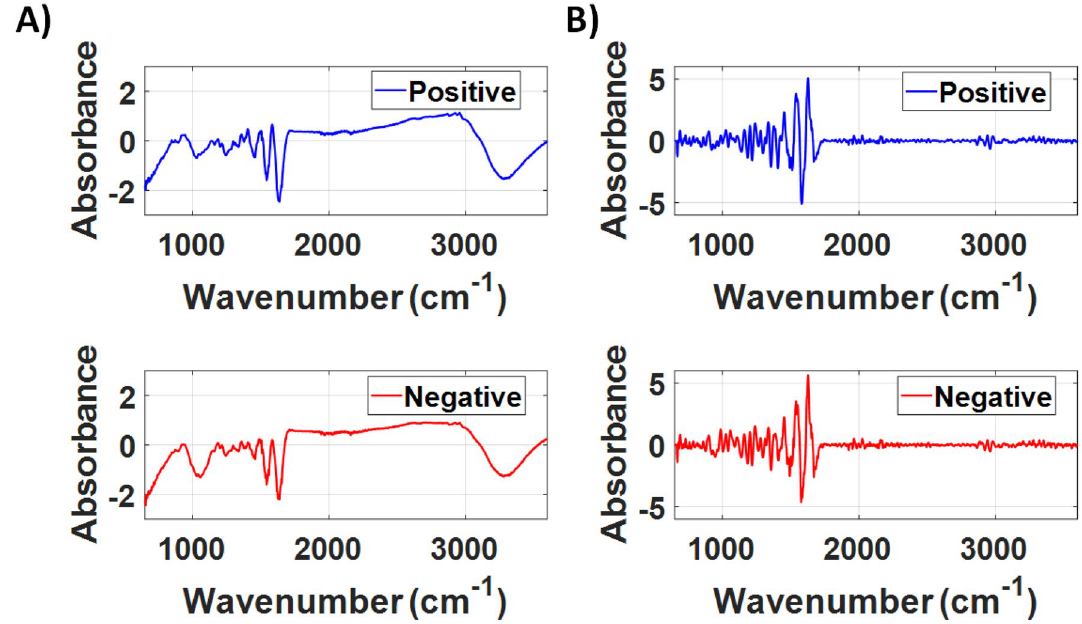
Figure 1. ( A ) Averaged FTIR spectra and ( B ) averaged second derivative of the FTIR spectra of the COVID-19 positive and negative groups of the LIQUID 1